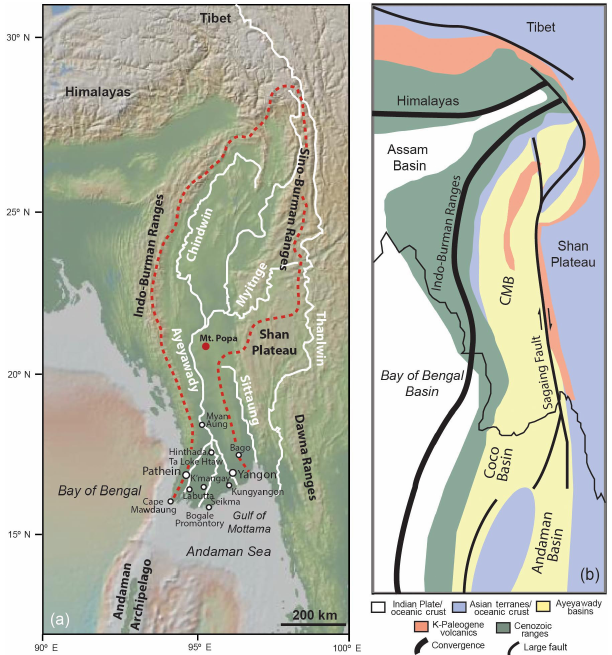
Figure 1. (a) Physiography and (b) geology of the Ayeyawady basin and adjacent